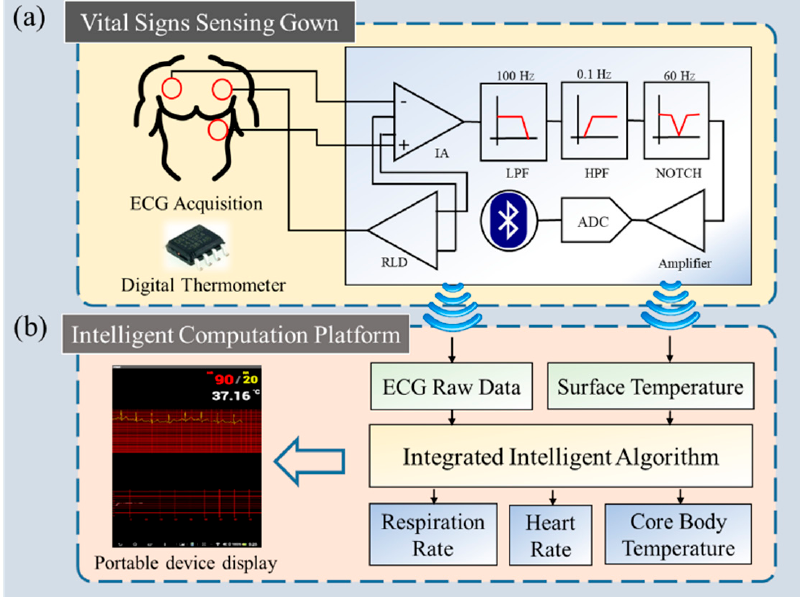
Figure 1. System architecture of long-term vital signs monitoring system. The system consists of two components: ( a ) a sensing gown which acquires lead II ECG signal and surface temperature with the embedded miniaturized circuit, and ( b ) a computation platform. The signals obtained by the gown are pre-processed within, and then transmitted to the computation platform. (RLD, IA, LPF, HPF, NOTCH, and ADC denote right leg driver, instrumentation amplifier, low pass filter, high pass filter, notch filter, and analog-to-digital converter, respectively).